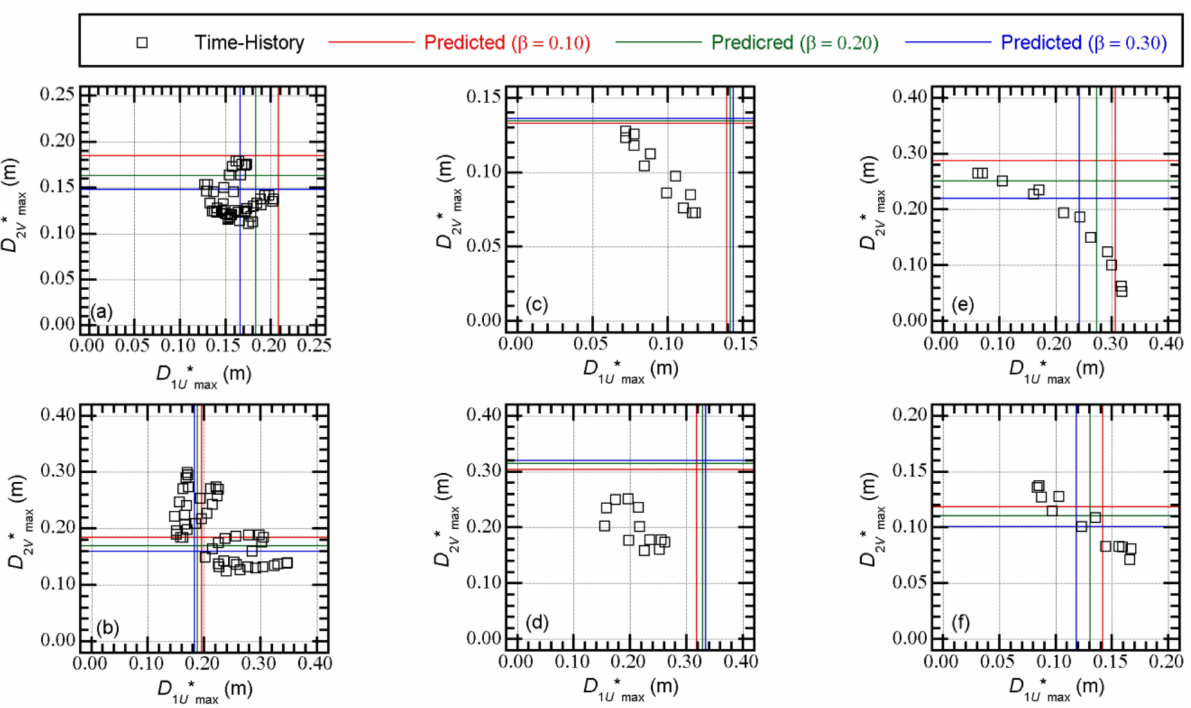
Figure 37. Accuracy of the predicted peak equivalent displacements of the first two modes (Model-Tf34): ( a ) Art-1 series; ( b ) Art-2 series; ( c ) UTO0414; ( d ) UTO0416; ( e ) TCU; ( f )